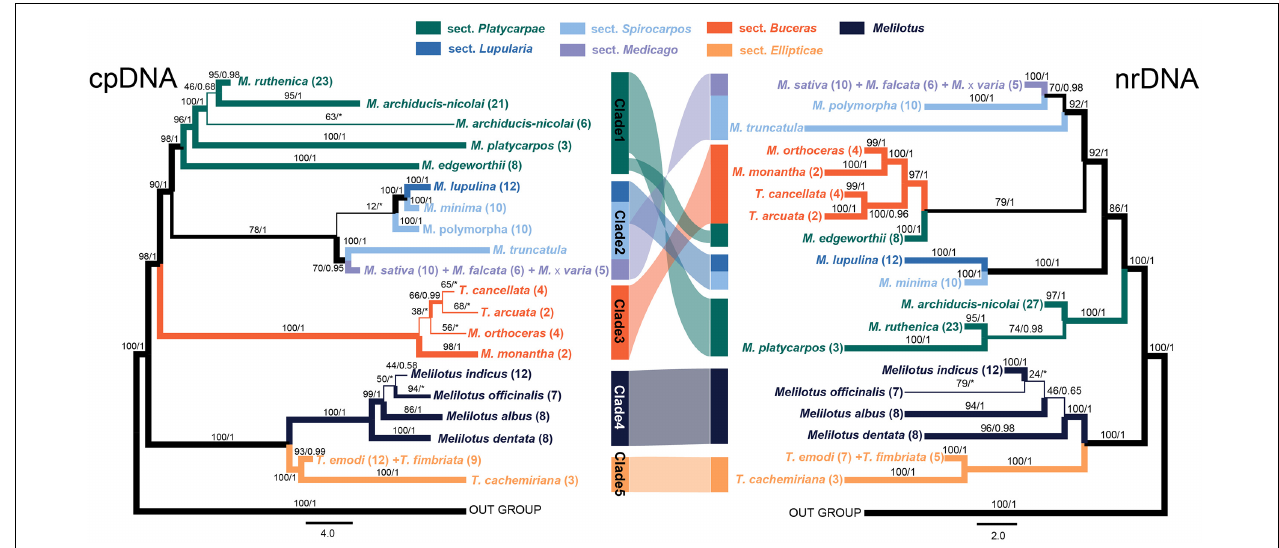
FIGURE 2 | Phylogenetic trees of the three genera, Medicago , Trigonella , and Melilotus reconstructed based on two cpDNA barcodes (left) and two nuclear markers (right). Colors represent Melilotus and different sections of Medicago and Trigonella . Maximum likelihood (ML) bootstrap values and Bayesian posterior probabilities are indicated. The thickest branches indicate high support from the ML and BI analyses (bootstrap values ≥ 80 and posterior probabilities ≥ 0.95), thinner branches indicate high support from one of the two analyses, and the thinnest branches indicate low support from both analyses. The congruence and incongruence between the two trees are represented by color-shaded connections. The two inverted connections indicate significantly incongruence interspecific-relationships within each